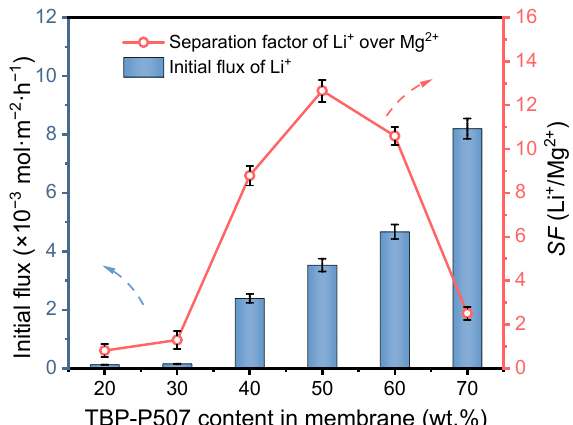
Figure 7. Li + separation performance of the PIMs with different contents of carrier (P507-TBP). Feed solution: 0.1 mol/L LiCl; 4.0 mol/L MgCl 2 ; 0.13 mol/L FeCl 3 ; test time: 24 h; n = 5.